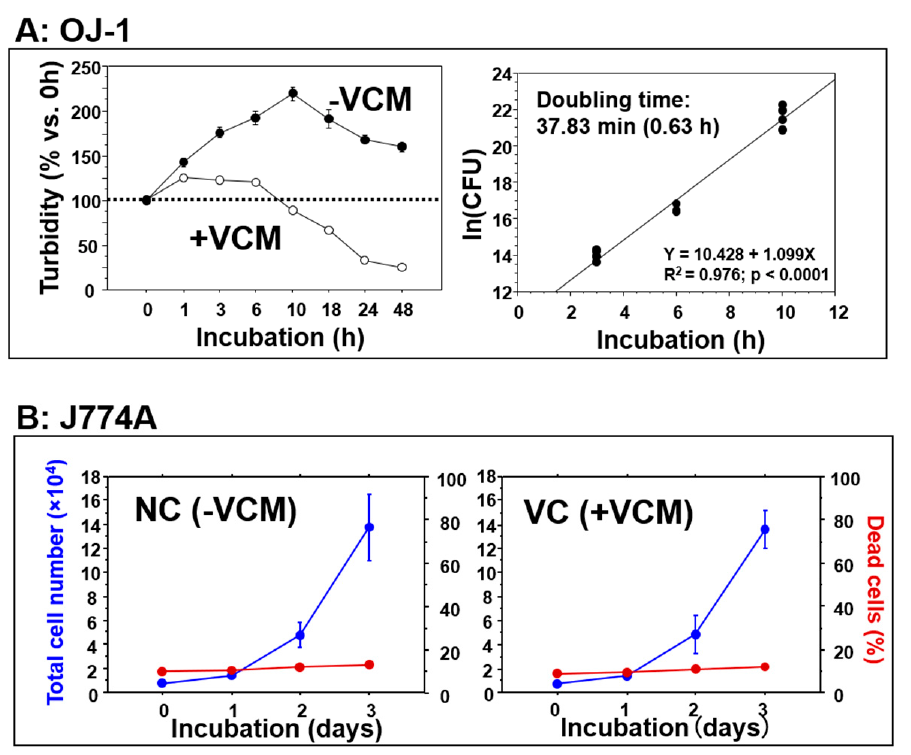
Figure 1. The effects of VCM. ( A ) The time course of the proliferation activity of OJ-1 (% of CFU) incubated with VCM (+VCM) and without VCM ( − VCM) at a concentration of 48 µ g/mL in 10% FBS containing DMEM. The − VCM group showed exponential growth in the initial 10 h of incubation, which was also seen by a doubling time analysis (right panel). Data: mean ± S.D. ( N = 3). ( B ) The time course of the proliferation activity of J774A cells incubated without VCM (NC group: − VCM) (left panel) and with VCM (VC group: +VCM) at the concentration of 48 µ g/mL in 10% FBS containing DMEM. Red lines show the percent of dead cells. Data: mean ± S.D. ( N = 3).